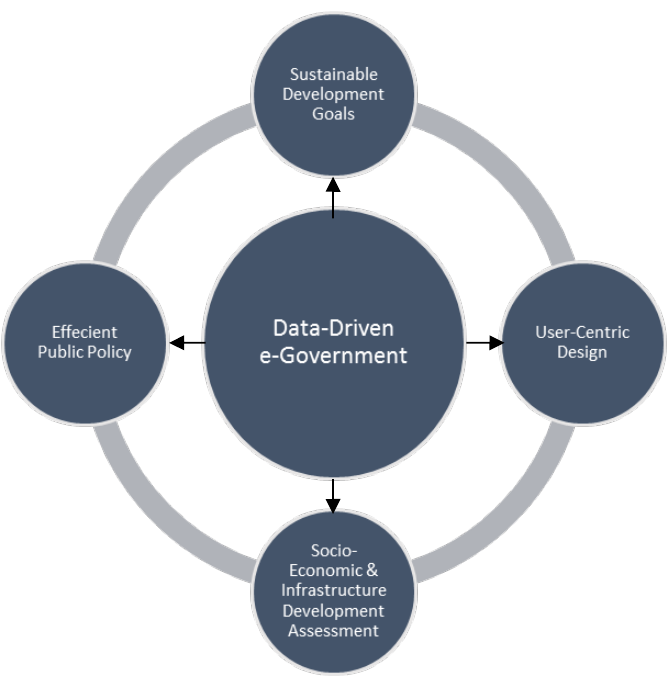
Figure 1: Objectives of Data-Driven